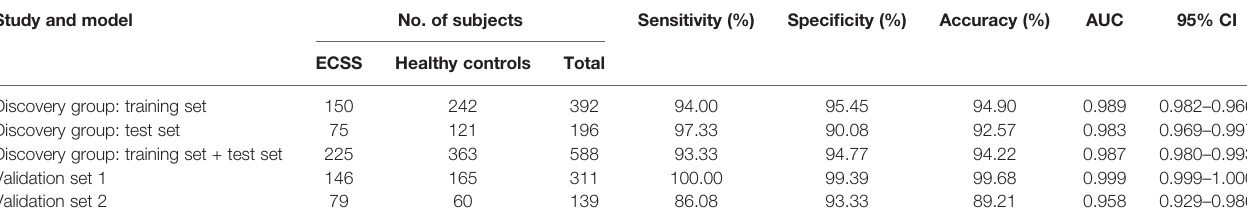
TABLE 1 | Performance for ESCC diagnosis of metabolite biomarkers on the training set and validation sets. Study and